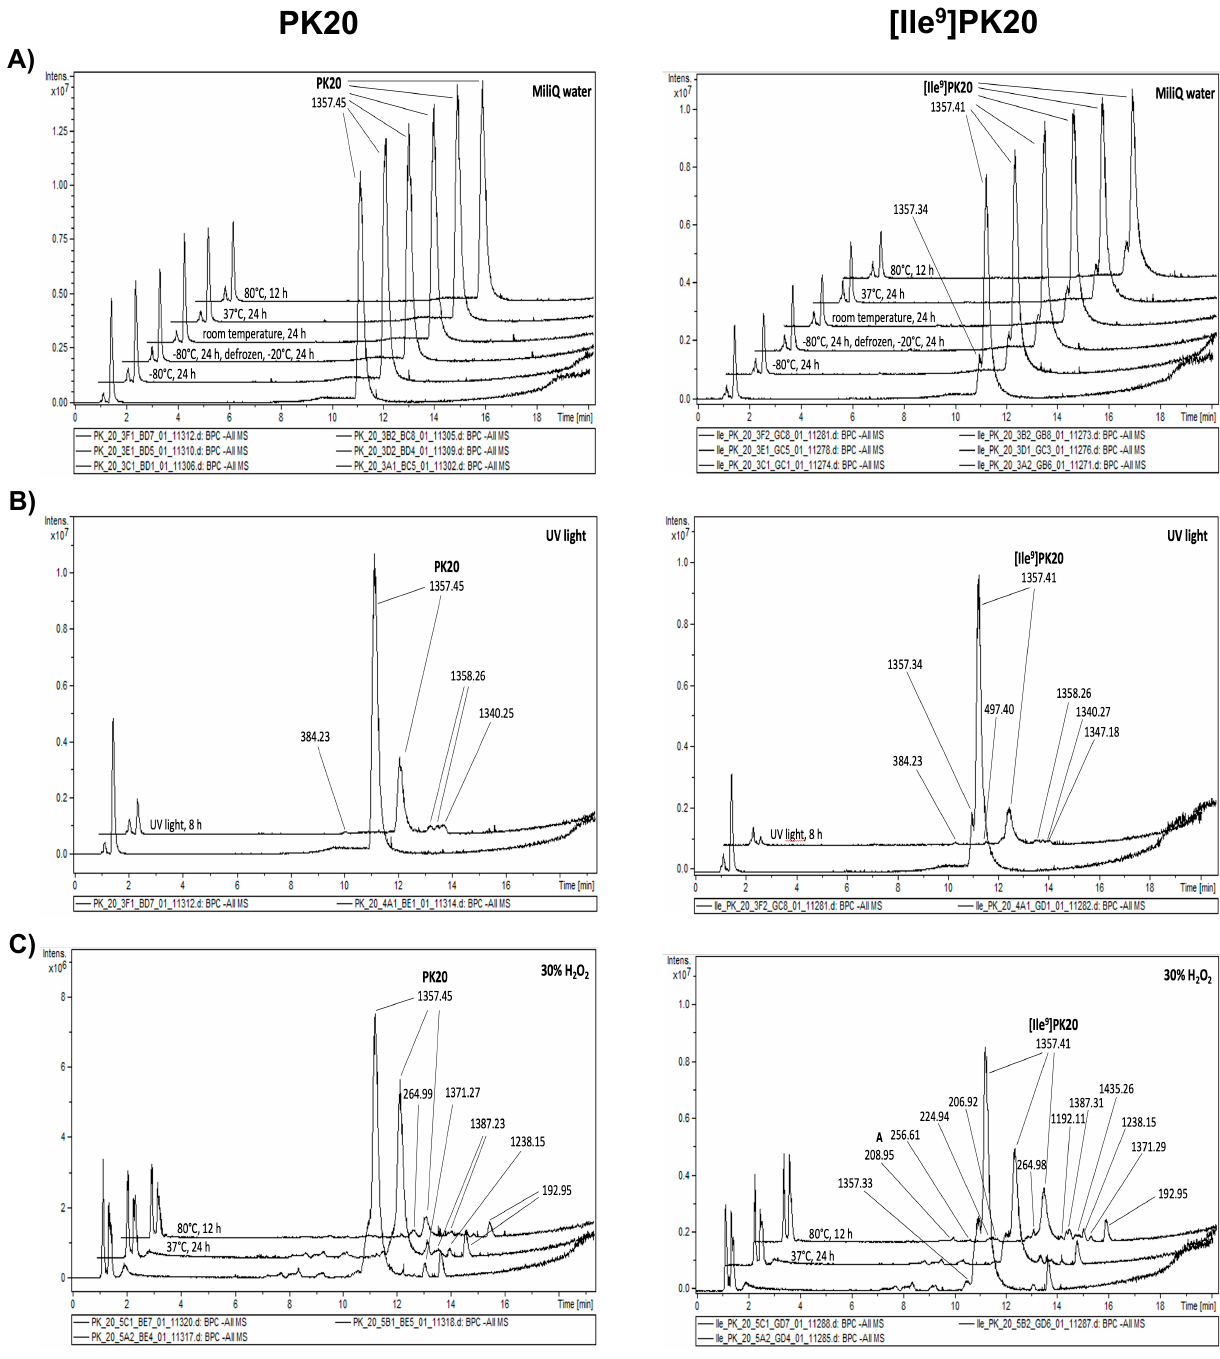
respectively) and time of exposure (panel ( C ) and ( D ), respectively). Chromatograms show degra- dation products with corresponding molecular weights.